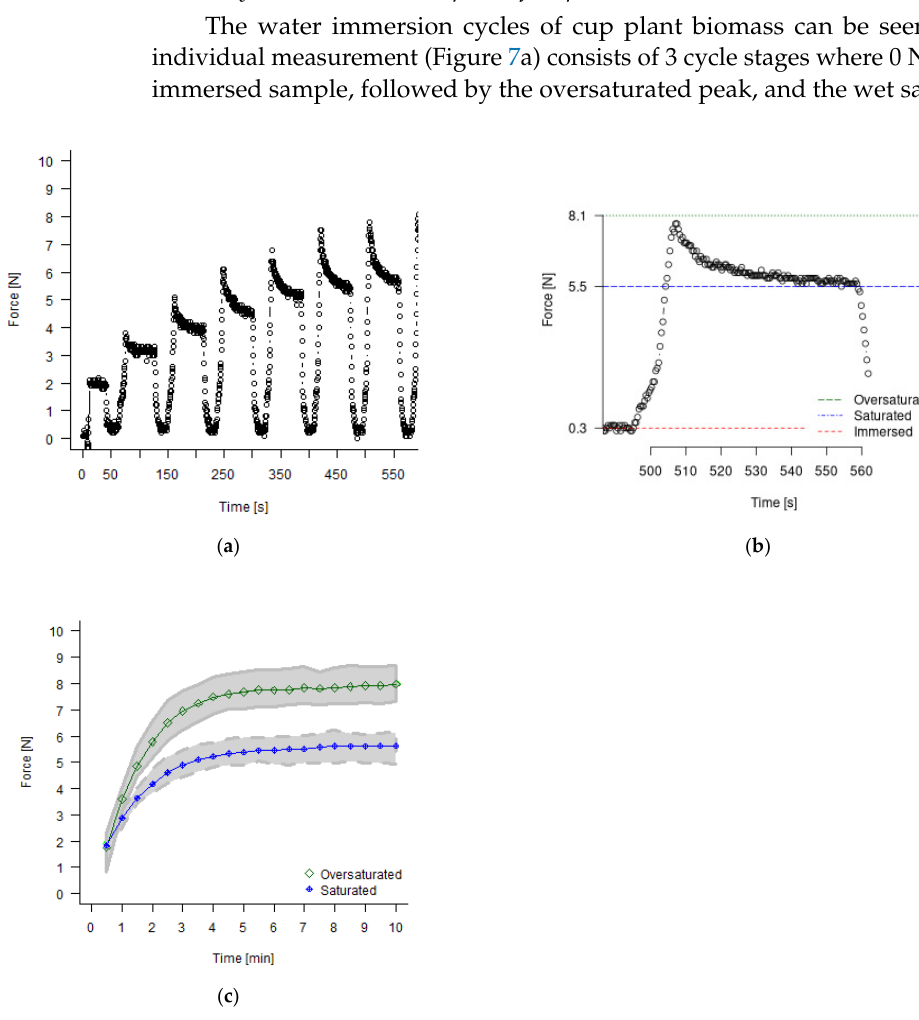
Figure 7. Increasing water uptake as function over time at short wetting intervals. ( a ) Force against time of cyclic wetting; ( b ) individual force in dependence of time result of a single soaking cycle. The horizontal lines represent the three stages of soaking in water followed by dripping of adsorbed water until the wet aggregates are saturated with absorbed water; ( c ) force against time result as mean values of the oversaturated and saturated values. The grey area represents the value range of all samples [ n = 6].